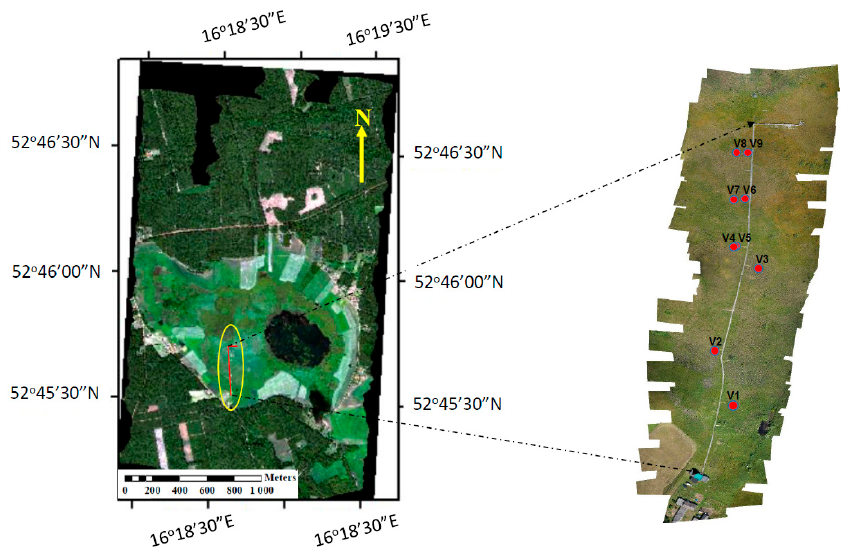
Figure 2. Location of the ground validation plots (V1–V9) at the Rzecin peatland area during the SWAMP campaign on 11 July 2015. The plots were located on both sides of the boardwalk shown in the UAV (Unmanned Aerial Vehicle) map. Table 2. Detailed description of the validation plots (V1 to V9) with the corresponding coordinates, dominant species, Leaf Area Index (LAI) of vascular plants, and fraction of photosynthetically active radiation absorbed by plant canopy